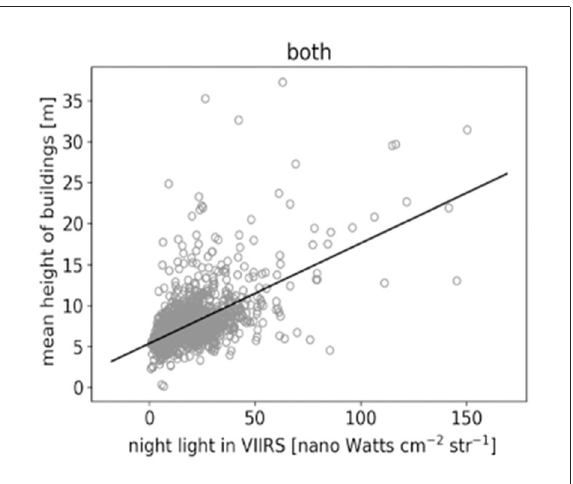
FIGURE3 Scatter plot of the night light and building height for land use ratio of more than